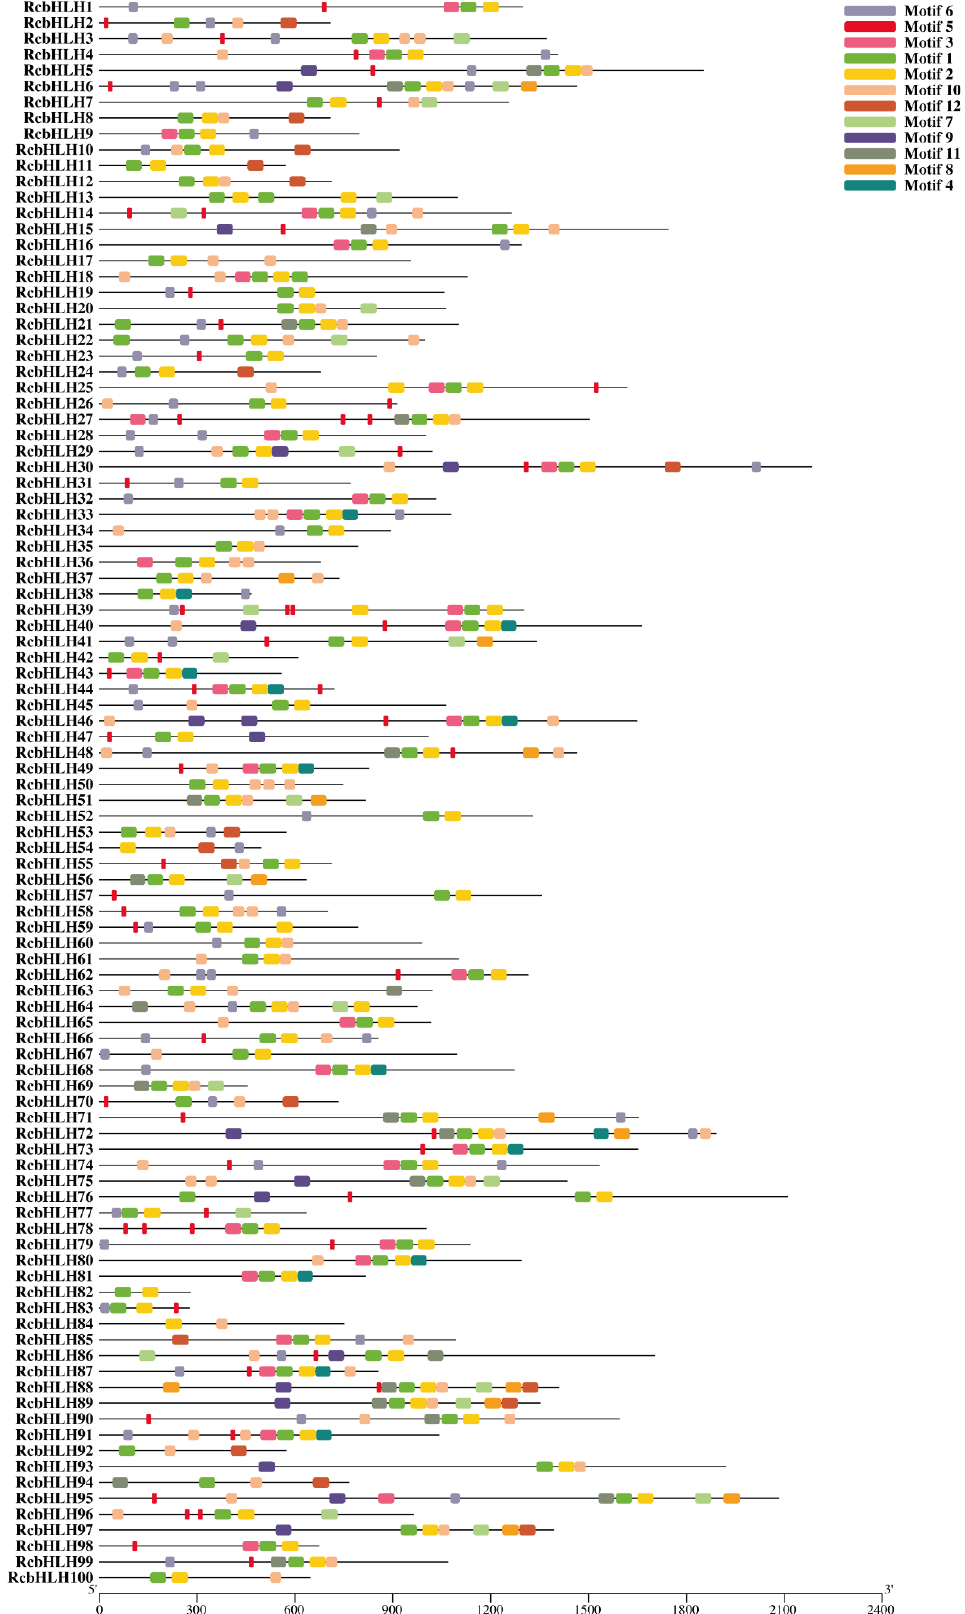
Figure 3. Prediction of motifs in RcbHLH gene members.